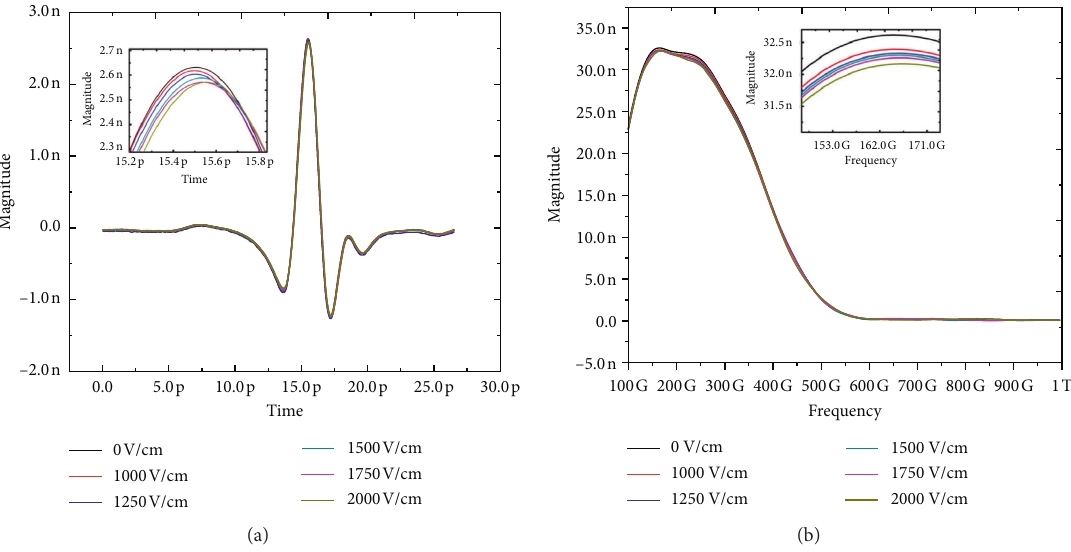
Figure 9: THz time domain spectrum (a) and frequency domain spectrum (b) with an applied vertical electric field.